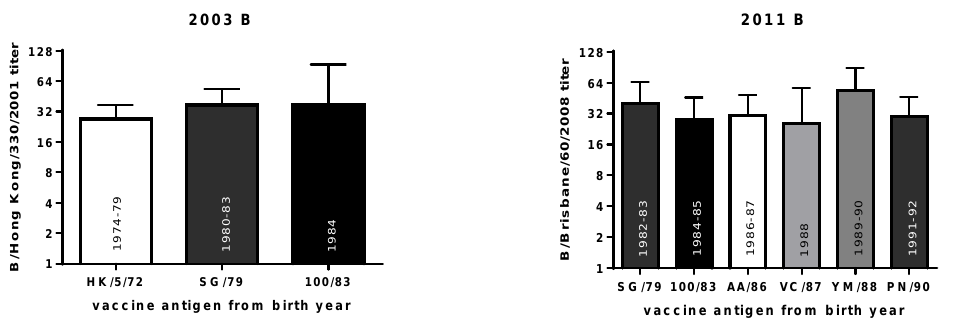
Figure 5. The geometric mean titers (with confidence interval) towards the vaccine antigens for the 2003 and 2011 cohorts based on antigens circulating after the year of birth. The year the antigens were recommended as vaccine strains are indicated inside the bars. The difference between sequential groups, born when different viruses circulated, was evaluated using the Mann Whitney rank test. *, p < 0.05; **, p < 0.01; and ***, p < 0.001. The viruses used for HI titer are A/New Caledonia/20/1999 (H1N1), A/Moscow/10/1999 (H3N2), and B/Hong Kong/330/2001 (Victoria lineage) for the 2003 cohort. The viruses used for testing HI titer are